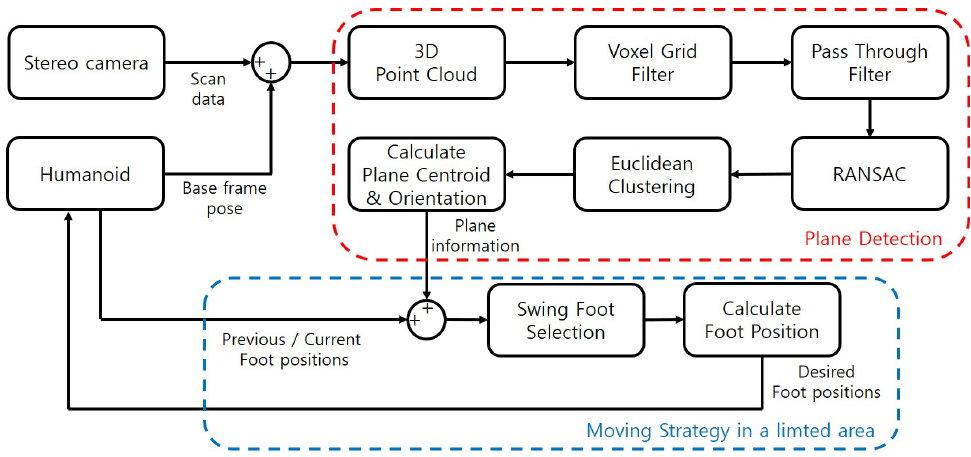
Figure 1. Pipeline of footstep